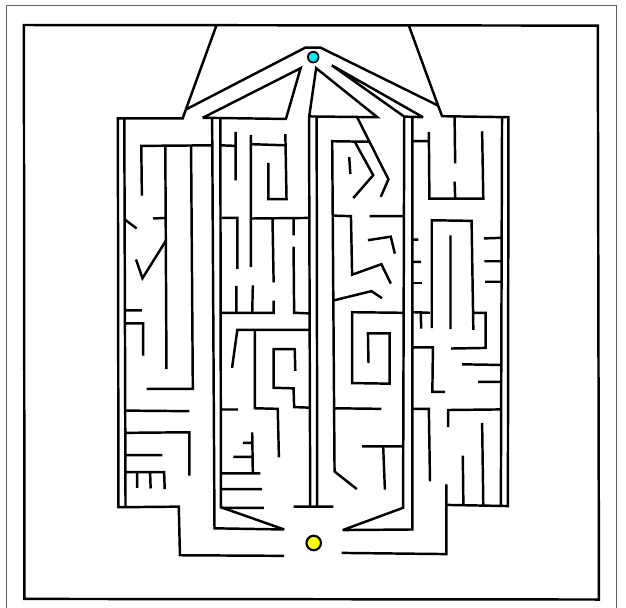
FigUre 2 | asymmetric gauntlet . Individuals start at the bottom point and must navigate to the goal at the top of the maze. Because of the variation between maze legs, reaching the goal is easier by some routes than others. The presence of multiple paths through the maze increases the various potential driving strategies that can reach the